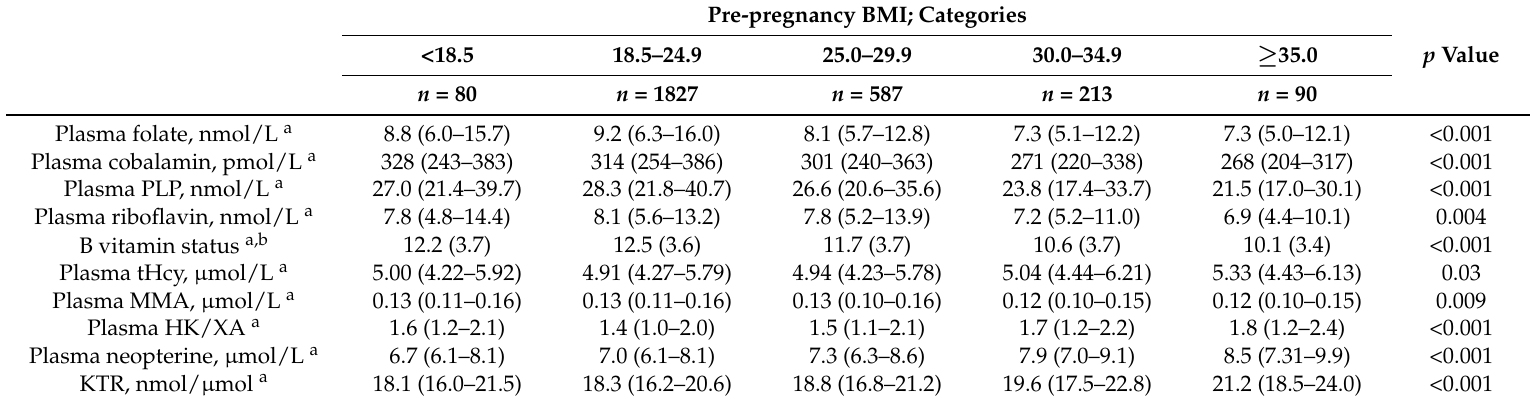
Table 2. Maternal plasma levels of vitamins, metabolic and inflammation markers in pregnancy week 18 according to pre-pregnancy BMI, n =